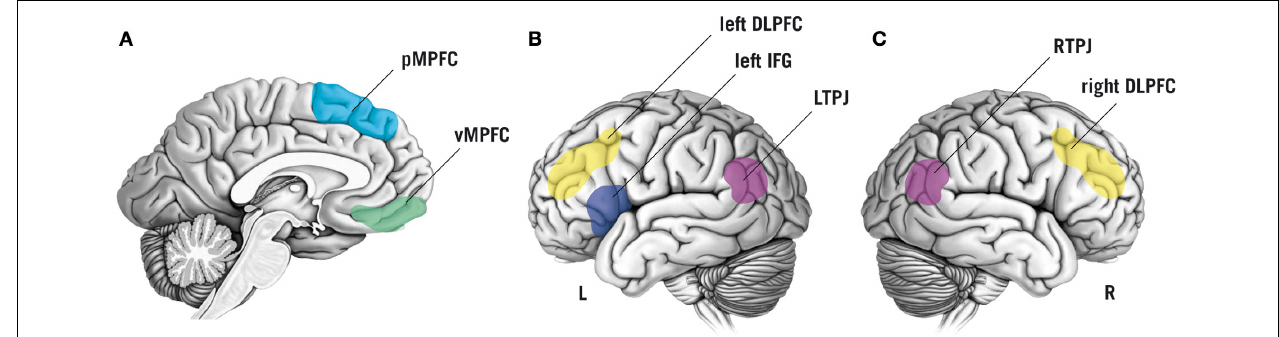
FIGURE 1 | Schematic overview of brain regions that have been targeted by non-invasive brain stimulation to study functional and dysfunctional mentalizing. Color labels are approximate. (A) Sagittal view of the brain showing the posterior medial prefrontal cortex (pMPFC, indicated in light-blue) and the ventromedial prefrontal cortex (vMPFC, in green). (B)